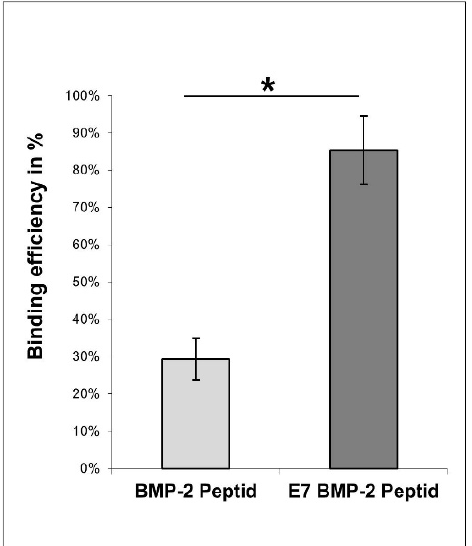
Figure 3. Indirect quantification of BMP-2 mimicry peptides binding to HA. BMP-2 mimicry peptides (1 mg / mL) with or without E7 Tag were incubated with equilibrated HA particles for 2 h at